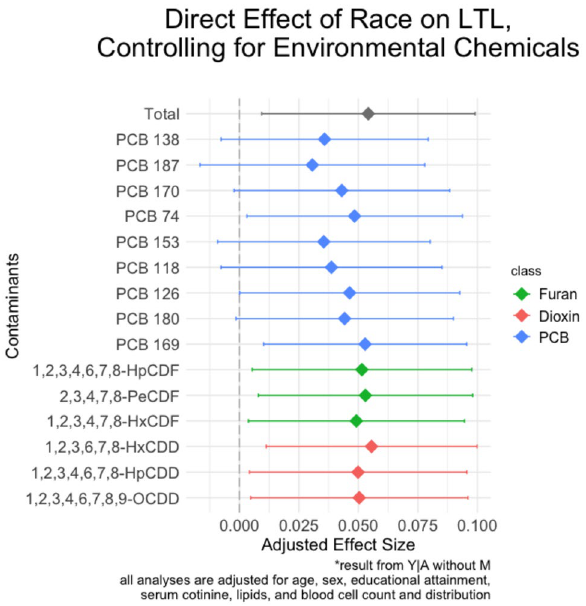
Figure 5. Results of the direct effect of self-reported Black race on leukocyte telomere length, controlling for environmental chemicals. Point estimates and 95% confidence intervals are